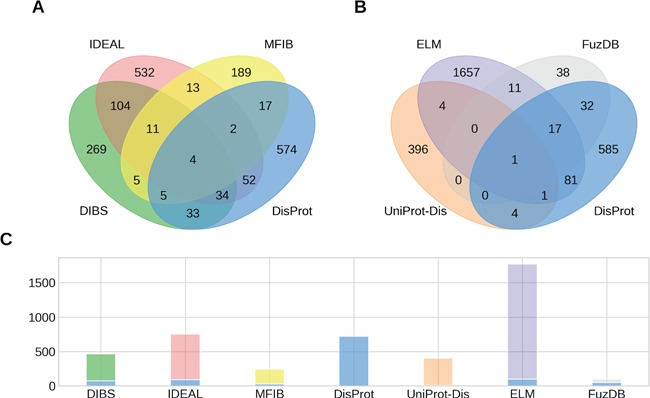
Overlap of IDPs annotated by multiple databases. (A, B) The Venn diagrams show the overlap between groups of four ID datasets. (C) The number of IDPs in each dataset is shown together with the fraction shared with DisProt (stacked blue bar).